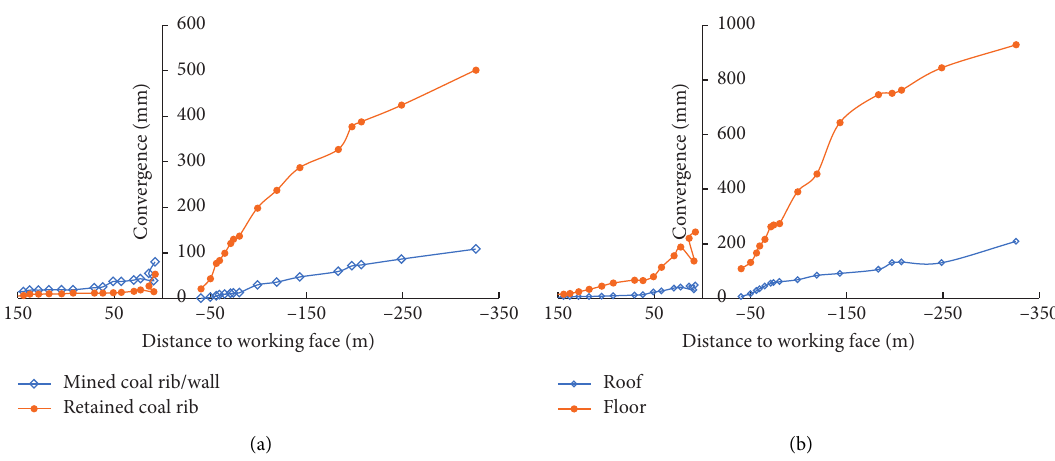
Figure 1: Surrounding rock convergence. (a) Rib/wall convergence. (b) Roof/floor convergence.